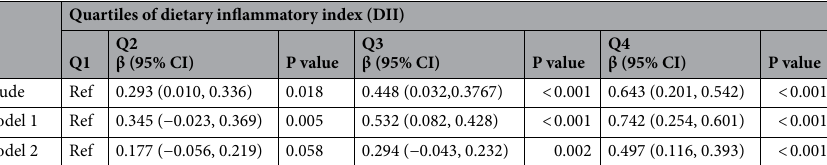
Table 4. Association between dietary inflammatory index and fatty liver index by l inear regression analysis. Model 1: Adjusted for age and sex. Model 2: Adjusted for age, sex, body mass index, waist circumference and physical